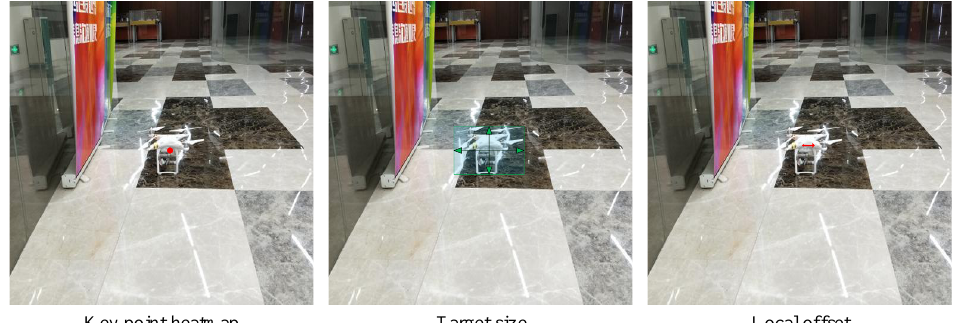
Figure 3. Outputs layer of cross-scale feature aggregation CenterNet (CFACN) and region-of-interest (ROI)-CFACN.